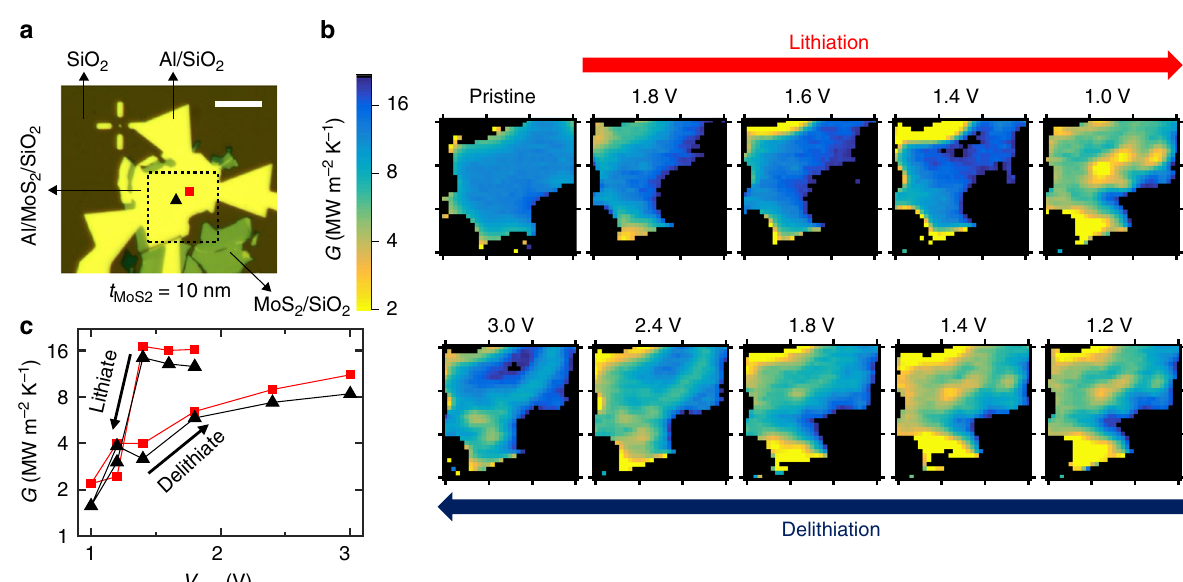
Fig. 2 Operando scanning thermal conductance imaging. a Optical micrograph of the 10 nm thick MoS 2 device. Thermal conductance images are measured within a 15 × 15 µ m square region marked by the dotted lines. The scale bar is 10 µ m. b Maps of the inhomogeneous thermal conductance within the device taken at different stages of lithiation and delithiation over one electrochemical cycle. These are measured after holding the MoS 2 device at a constant potential V WE (relative to Li + /Li) ranging from 1.8 V to 1.0 V for discharging (lithiation) and 1.2 V to 3.0 V for charging (delithiation). c Single-point thermal conductance vs. voltage, tracked over two spots that are indicated in a by the black triangle and red